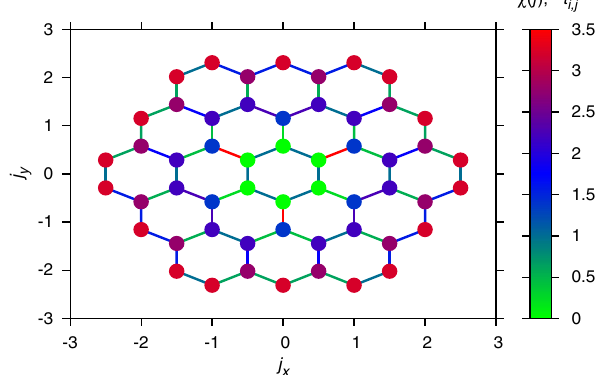
FIG. 1. A realization of strained honeycomb lattice that yields a finite axial magnetic field. Colors at each site correspond to the parameter χ in Eq. (3), which defines the modification of the hopping amplitude along each bond.